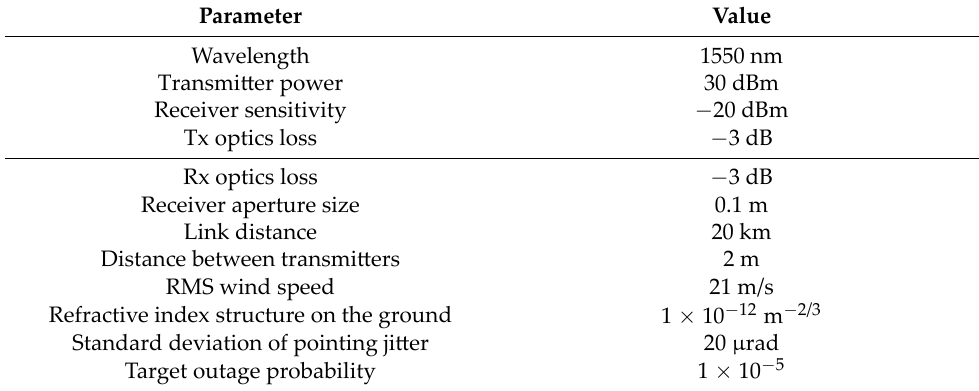
Table 1. Vertical FSO link